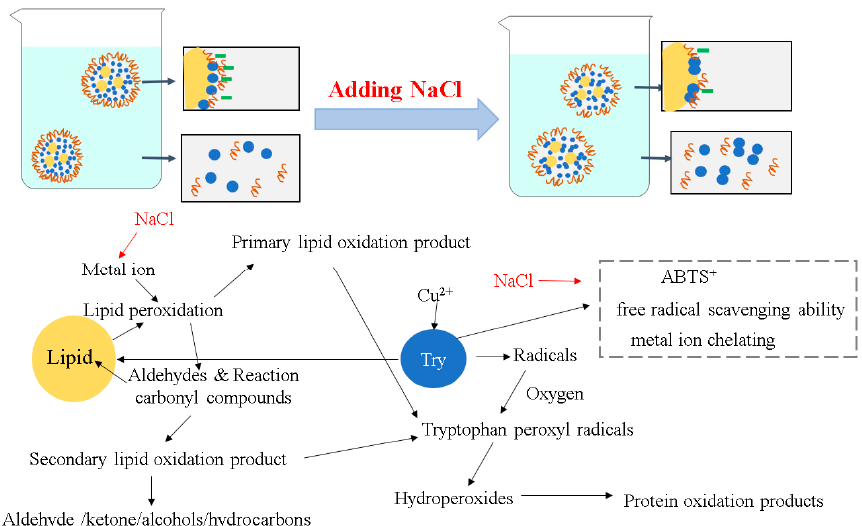
Figure 10. The pictorial mechanism of NaCl on the lipid and protein oxidation of filled